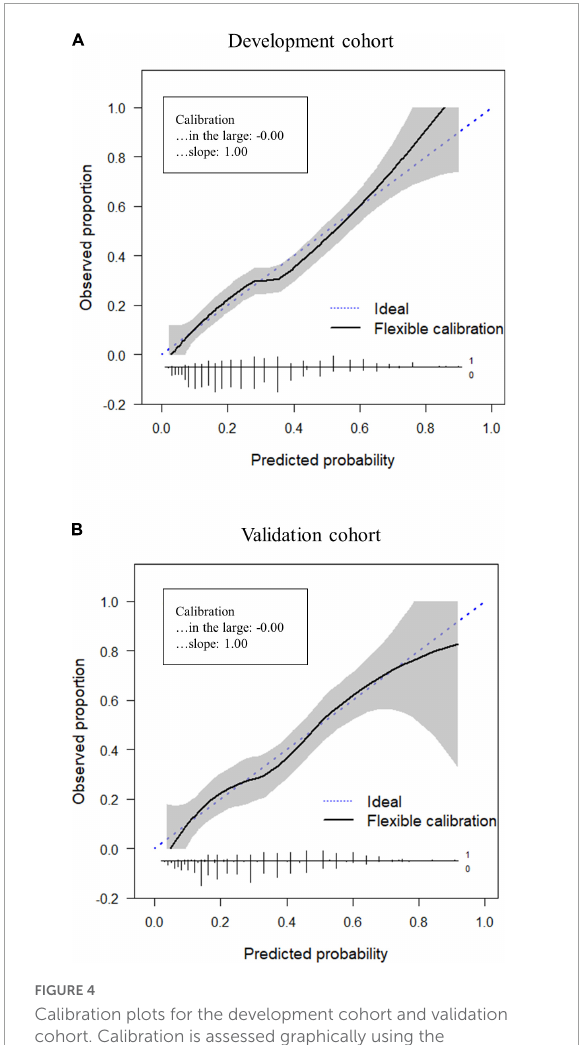
FIGURE4 Calibration plots for the development cohort and validation cohort. Calibration is assessed graphically using the non-parametric calibration curves with pointwise 95% confidence intervals, and their graphical summaries (calibration-in-the-large and calibration slope). (A) Development cohort. (B) Validation